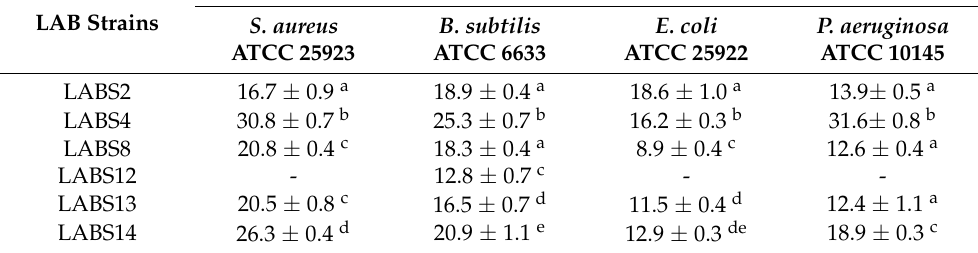
Table 5. Antibacterial activity of LAB strains (LABS2, LABS4, LABS8, LABS12, LABS13 and LABS14) isolated from the intestinal content of rainbow trout against indicator strains Staphylococcus aureus ATCC 25923, B. subtilis ATCC 6633, E. coli ATCC 25922 and P. aeruginosa ATCC 10145. Inhibition Halo (in mm) of Reference Bacterial Strains LAB Strains S. aureus B. subtilis E. coli P. aeruginosa ATCC 25923 ATCC 6633 ATCC 25922 ATCC 10145 LABS2